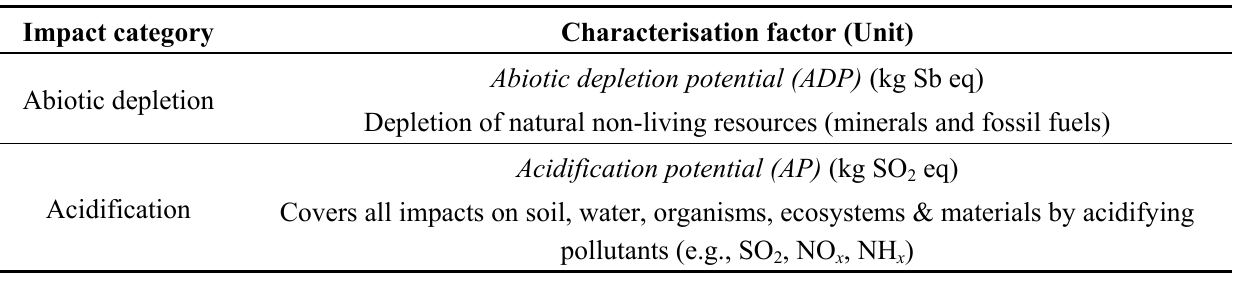
Table 3. Overview of the considered impact categories within the life cycle assessment according to the CML 2002 impact